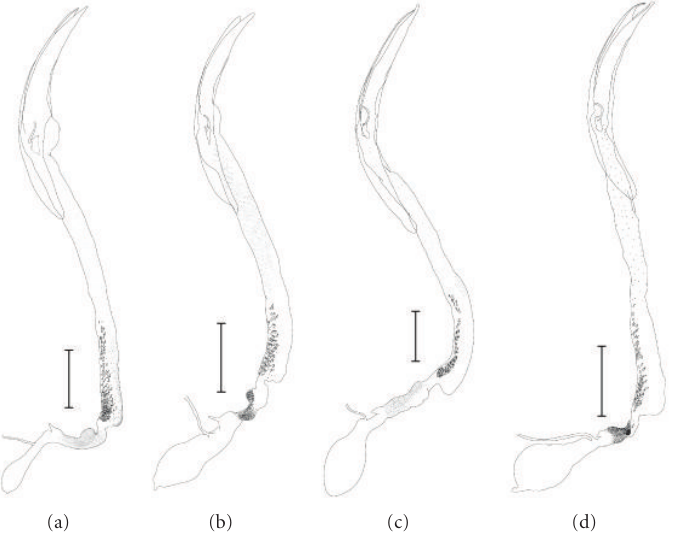
Figure 9: The median lobe with endophallus of Agelasta ( Dissosira ) spp. in lateral view. (a) A. ( D. ) catenata ; (b) A. ( D. ) perplexa ; (c) A. ( D. ) rufa ; (d) A. ( D. ) konoi . Scale: 1.0 mm.